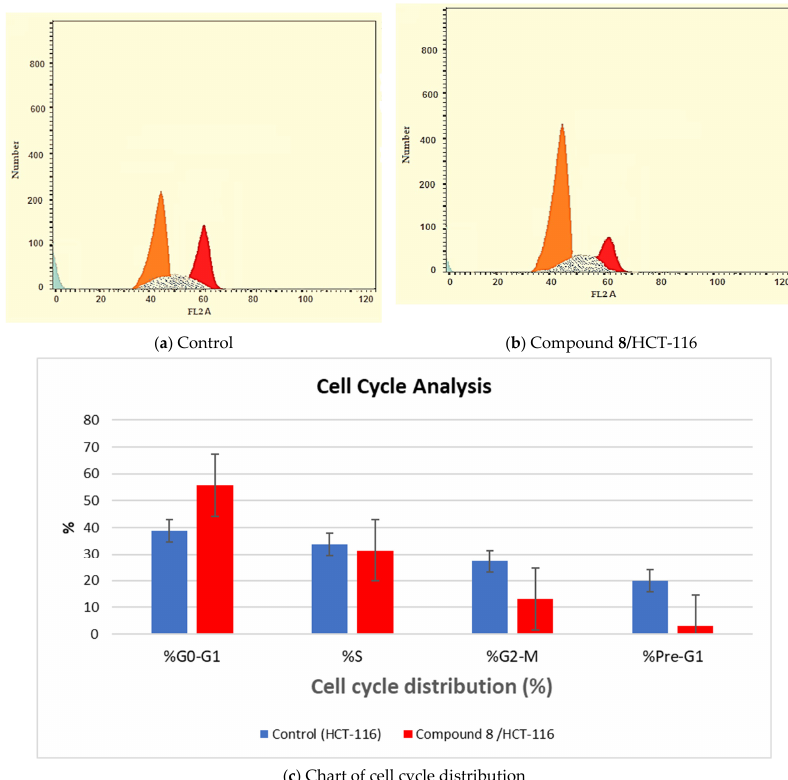
Figure 3. Flow cytometric analysis of cell cycle phases of HCT-116 cells after exposure to compound 8 (5.4 µM) after treatment for 24 h. (5.4 µ M) after treatment for 24